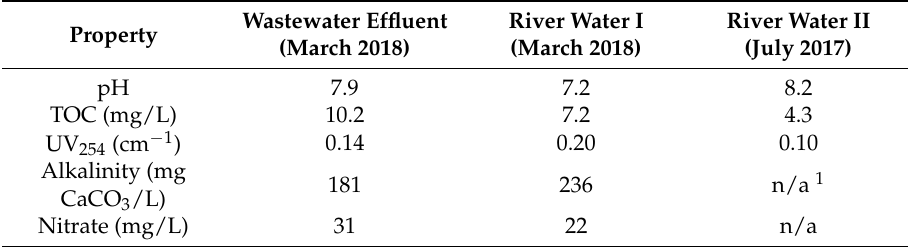
Table 2. Water sample characteristics. TOC: total organic